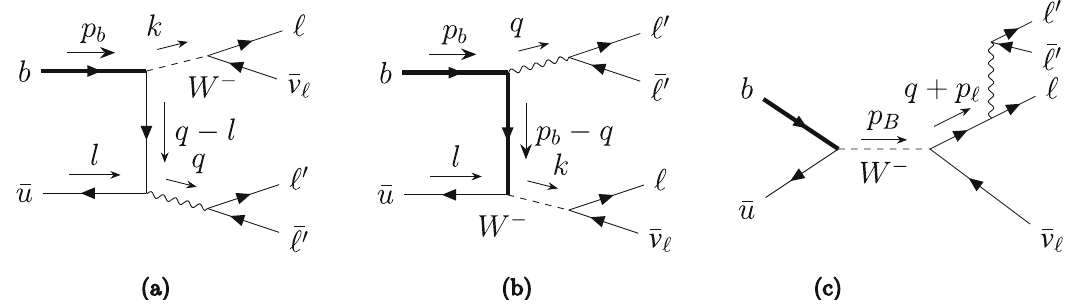
Fig. 2 Photon emissions that contribute to the tree-level B − → (cid:2) ¯ ν (cid:2) (cid:2) (cid:2) ¯ (cid:2) (cid:2) amplitude. The emission from the spectator quark ( a ) contributes at leading power whereas the emission from the heavy quark ( b ) and the lepton ( c ) is power suppressed ξ( q 2 , v · q ) . For q 2 → 0 we recover the result for the on- shell B − → (cid:2) ¯ ν (cid:2) γ form factors